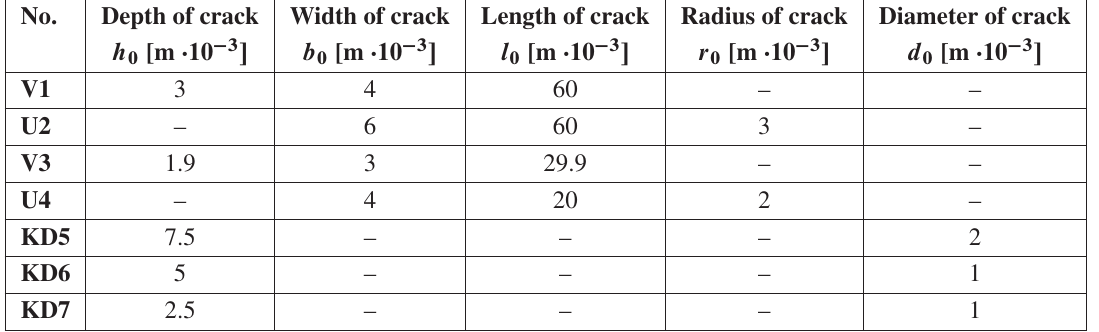
Table 2. Dimensions of crack before simulation.